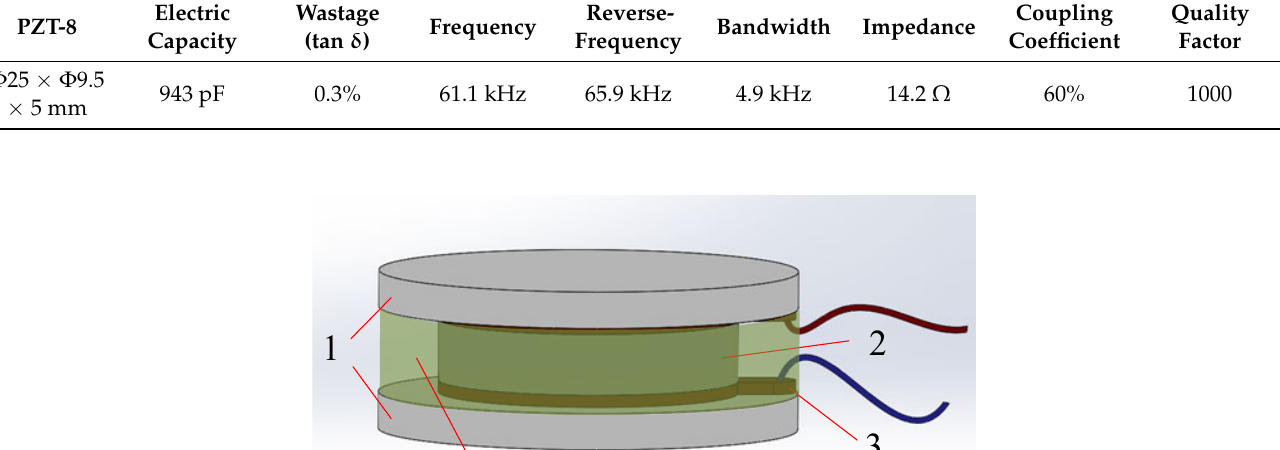
Table 1. Piezoelectric properties of PZT-8.